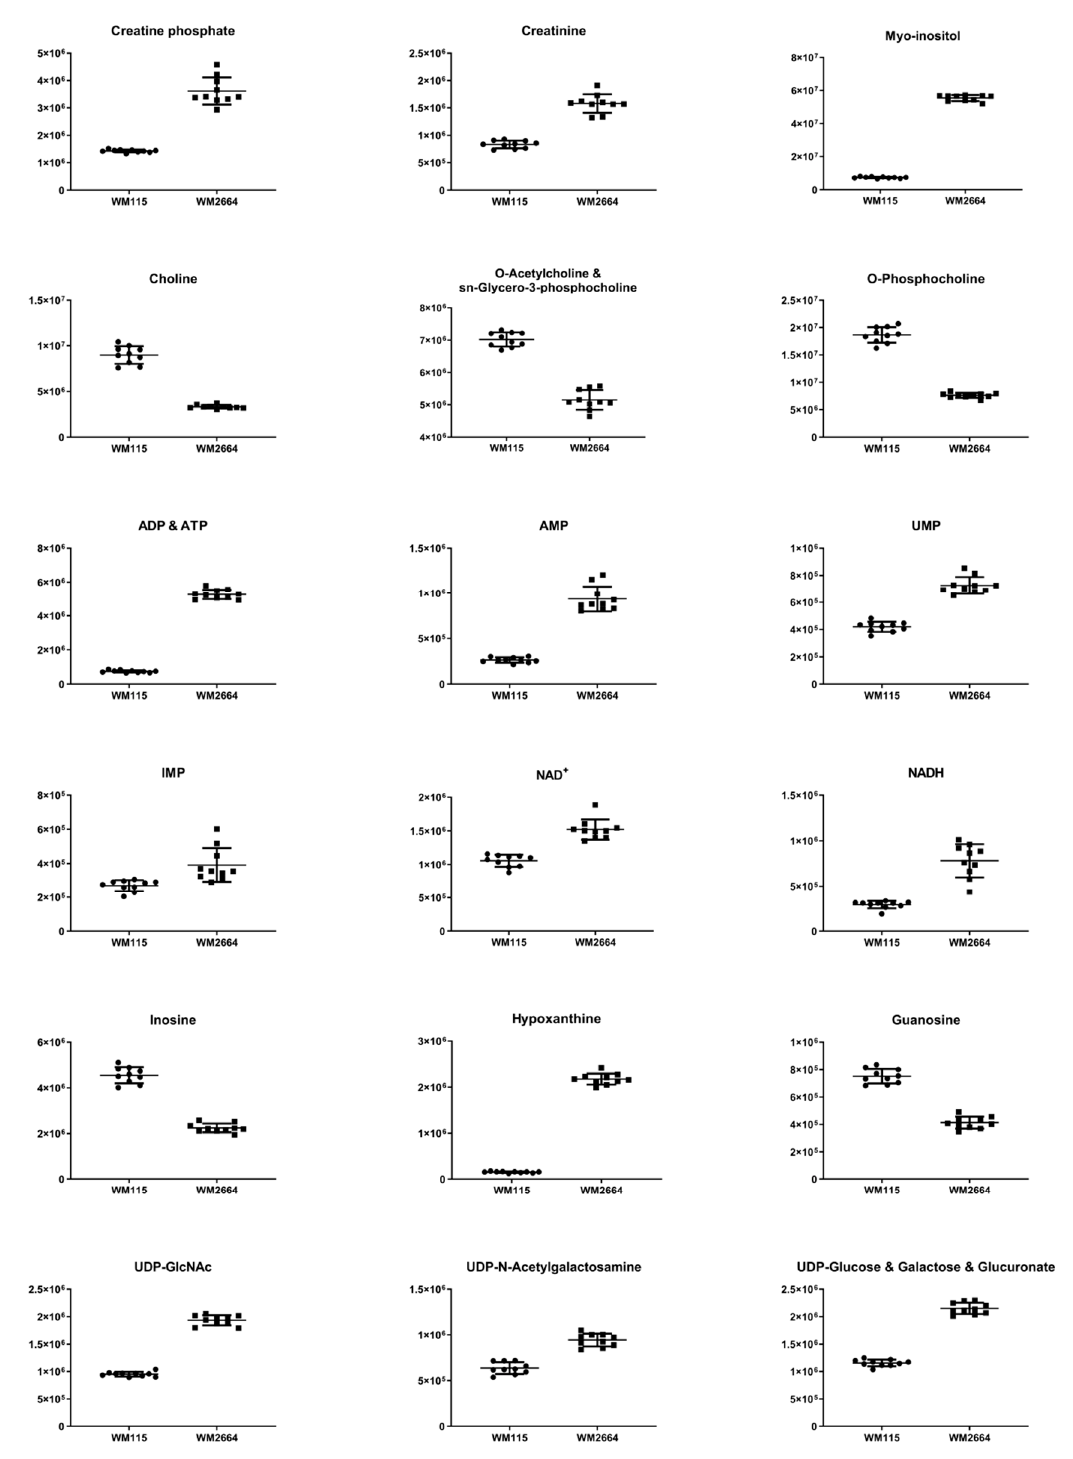
Figure 3. Boxplots for melanoma-originated metabolites (AUC ≥ 0.9) that have been herein identified in NMR data.